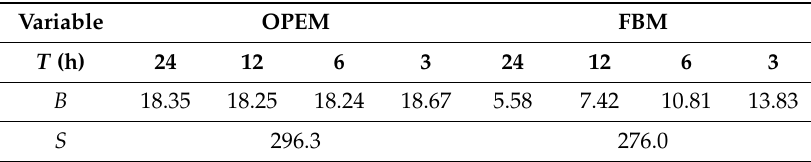
Table 12. HESS cycling performances (in